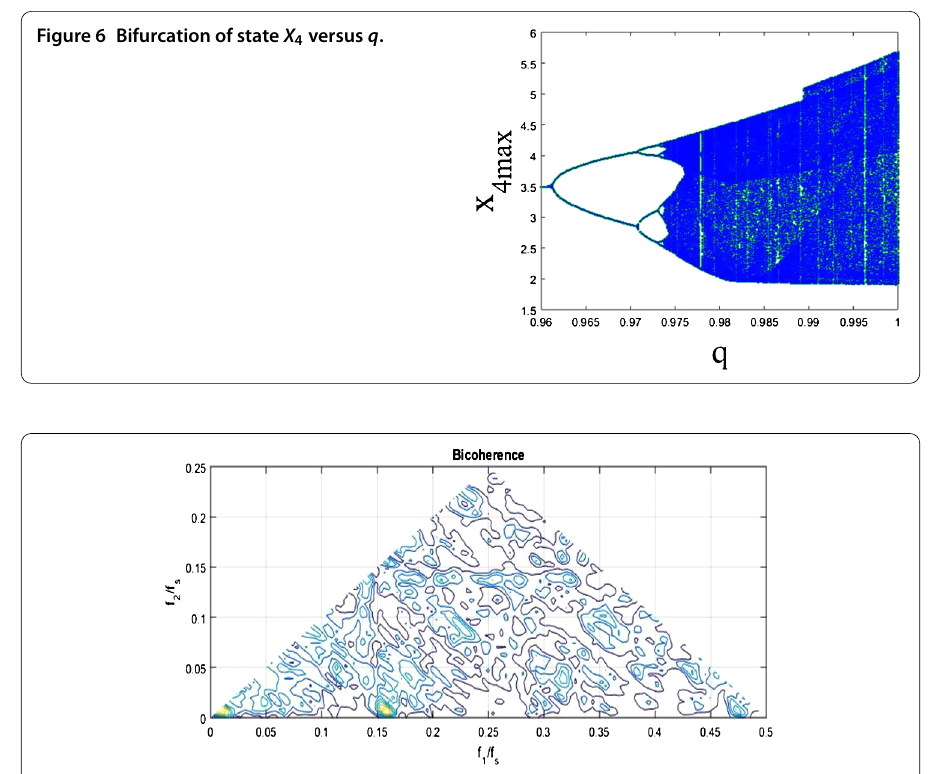
Figure 6 Bifurcation of state X 4 versus q .